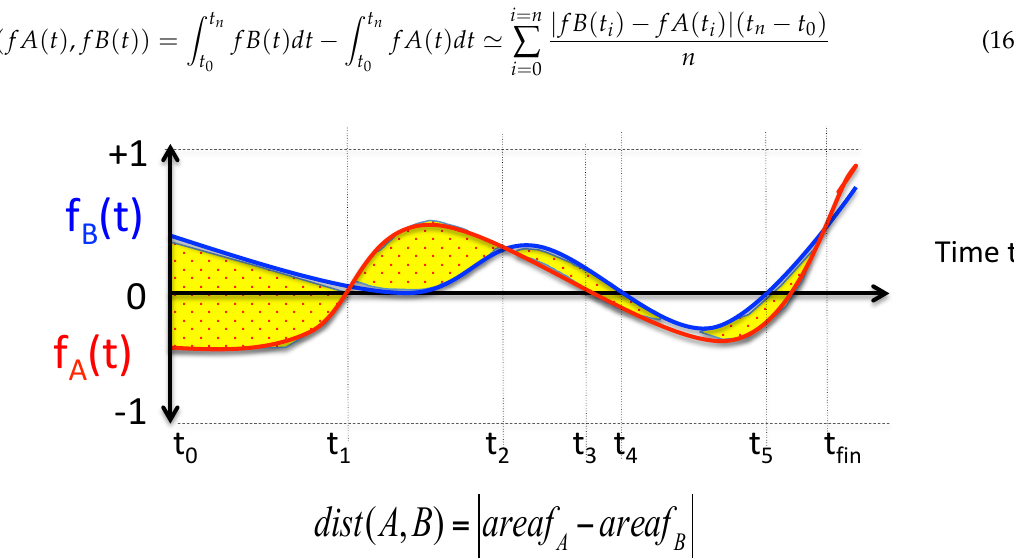
Figure 13. CBR: Distance is the difference of areas of f A and f B